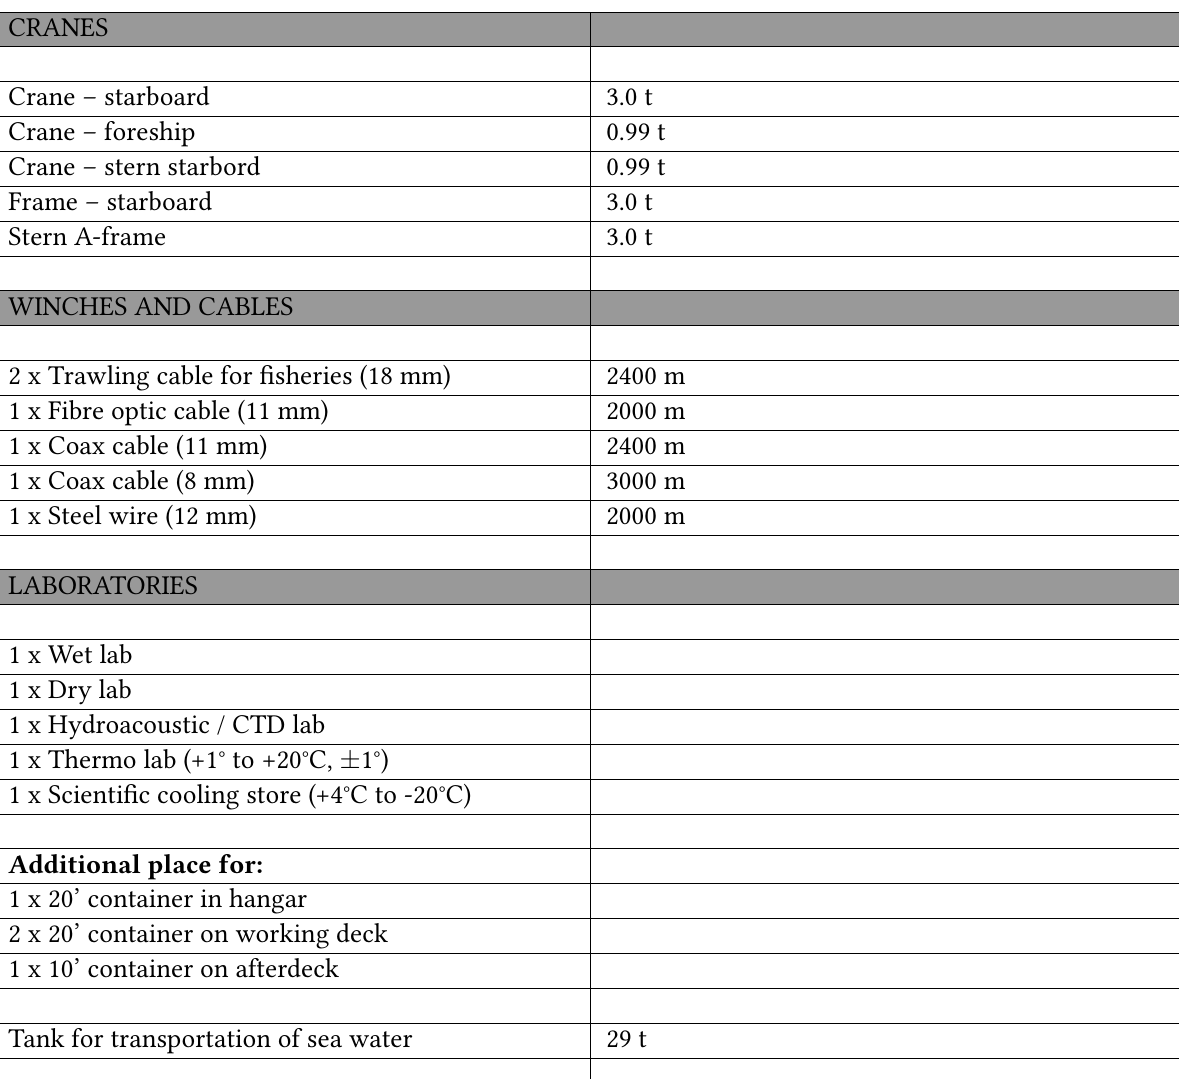
Table 2: Infrastructure for scientific work on